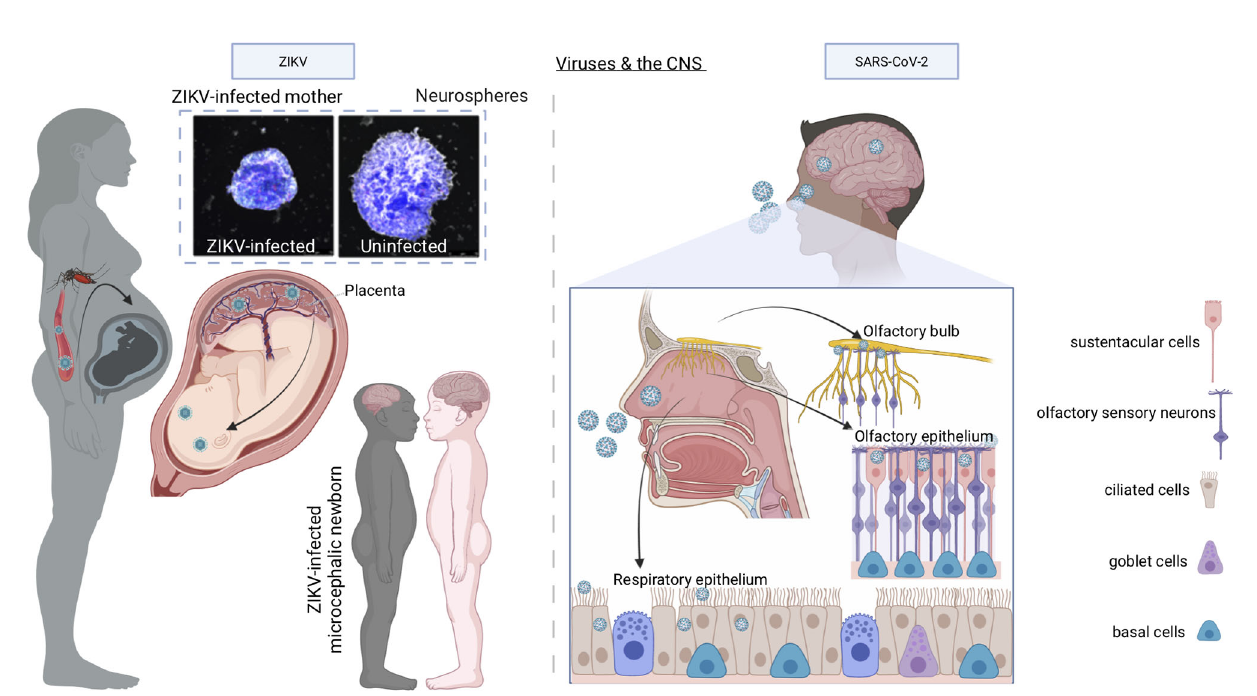
FIGURE 3 | Models of ZIKV and SARS-CoV-2 infection of the CNS. When ZIKV is transmitted to a pregnant woman by bites of infected Aedes mosquitoes, although it causes mild or no symptoms in the mother, it enters the bloodstream, breaches the placental barrier, and infects the developing CNS of the fetus, with devastating consequences including microcephaly, decreased brain tissue, damage to the posterior segment of the eye, hypertonia, and arthrogryposis. In vitro experiments with human neurospheres con fi rm the direct effect of ZIKV on neural cells. Once SARS-CoV-2 is inhaled into the nasal cavity, it infects the sustentacular cells of the olfactory epithelium using ACE2 receptor and multiplies causing infection of the olfactory epithelium, the respiratory epithelium, and olfactory bulb through the numerous ACE2 receptors expressed by the cells of these tissues. From the olfactory bulb, the virus may travel to the CNS by retrograde axonal transport along olfactory sensory